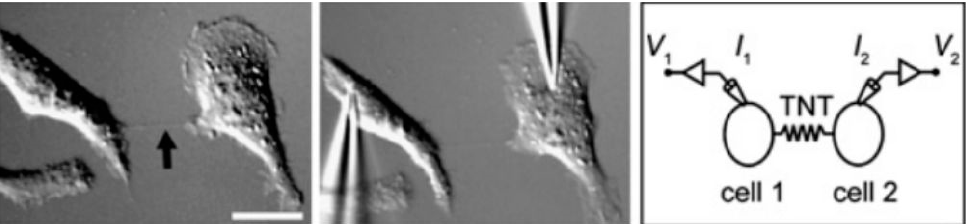
Figure 1. A micrograph illustrating filopodial “TNT” (tunnelling nanotubule) extensions between two normal rat kidney (NRK) epithelial cells (black arrow) ( Right ); during electrophysiological recordings ( Left ). Scale bar = 20 µm. V 1 and V 2 denote voltage applied to cell 1 and cell 2, and I 1 and I 2 denote the current injected into cell 1 and cell 2. These experiments indicated that filopodia electrically connect cells [37].